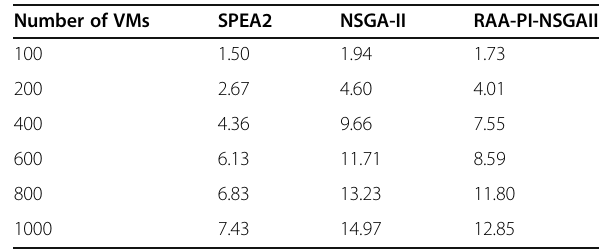
Table 5 Repetition rate of a solution set Table 6 Spacing metric of algorithm